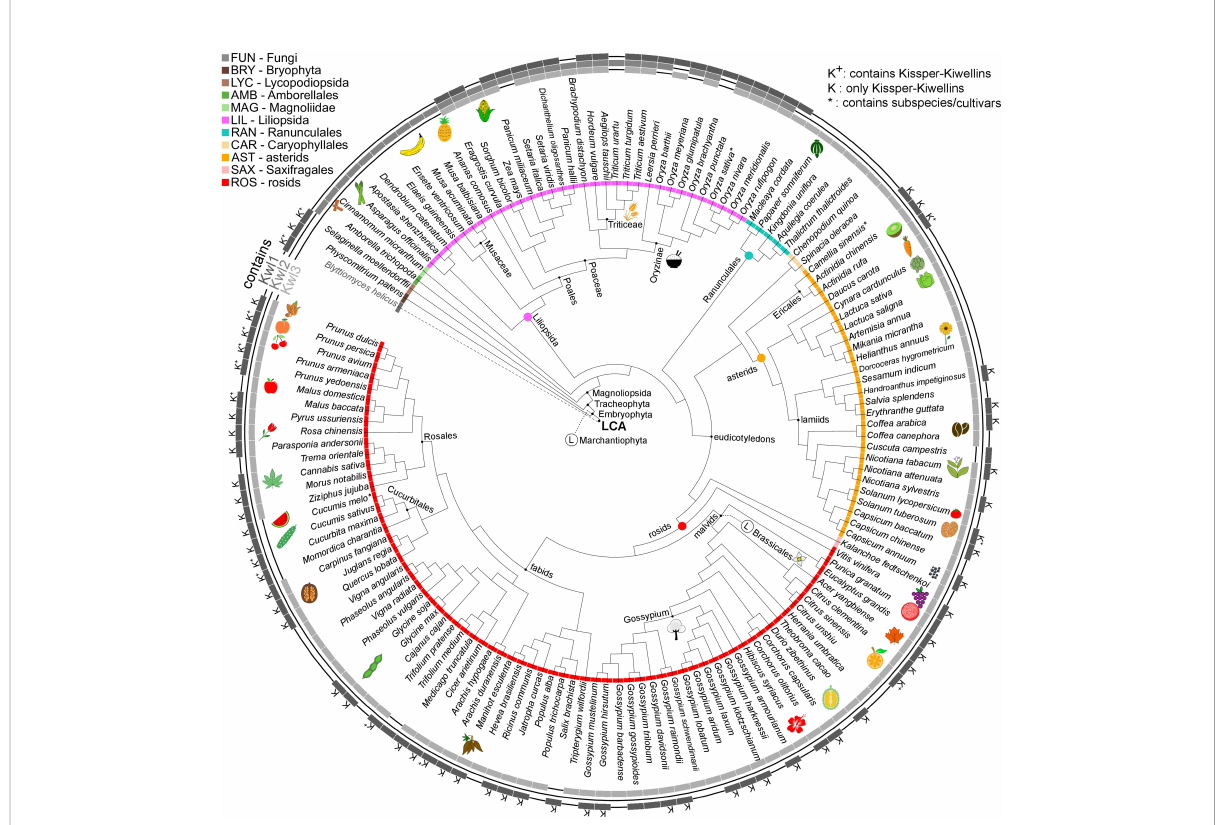
FIGURE 5 Species tree cladogram. The inner circle encodes taxonomic groups. The outer circle indicates if a species is found in the Kiwellin group Kwl1, Kwl2 or Kwl3. K + : Kwl1 contains Kissper-Kiwellins, K: only Kissper-Kwl1, *: contains subspecies/cultivars, Ⓛ : putative loss